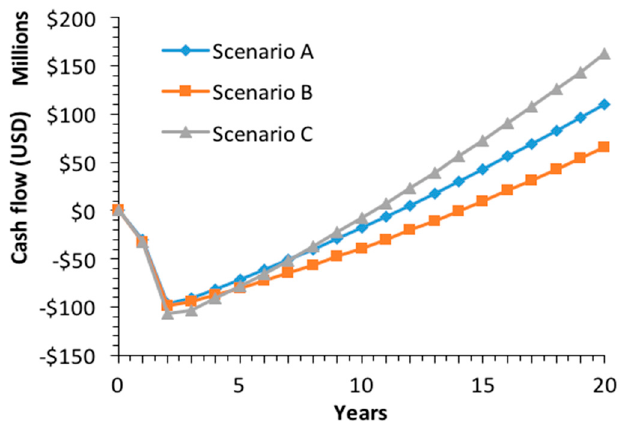
Figure 5. Cash flow diagram for the different scenarios.